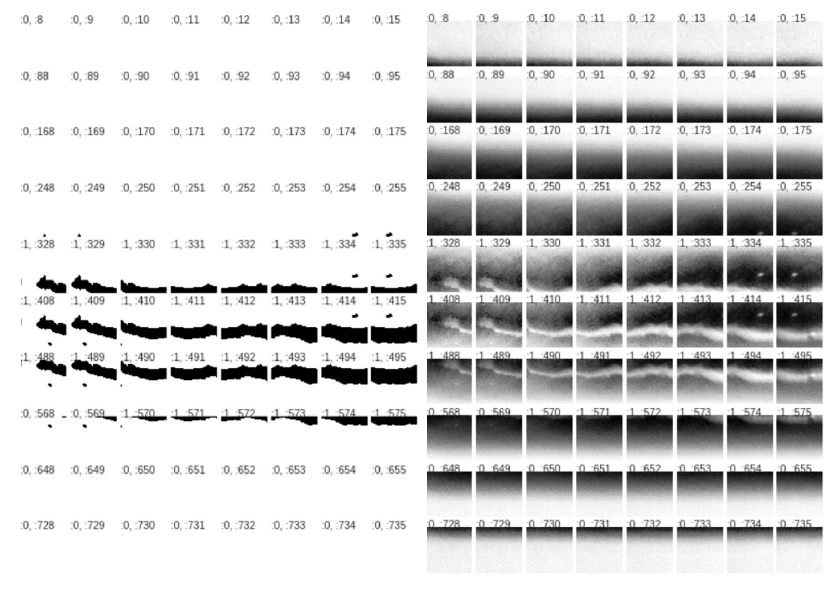
Figure 2. Examples of ground truths ( left ) and extracted patches ( right ), which are denoted as Class:PatchIndex.